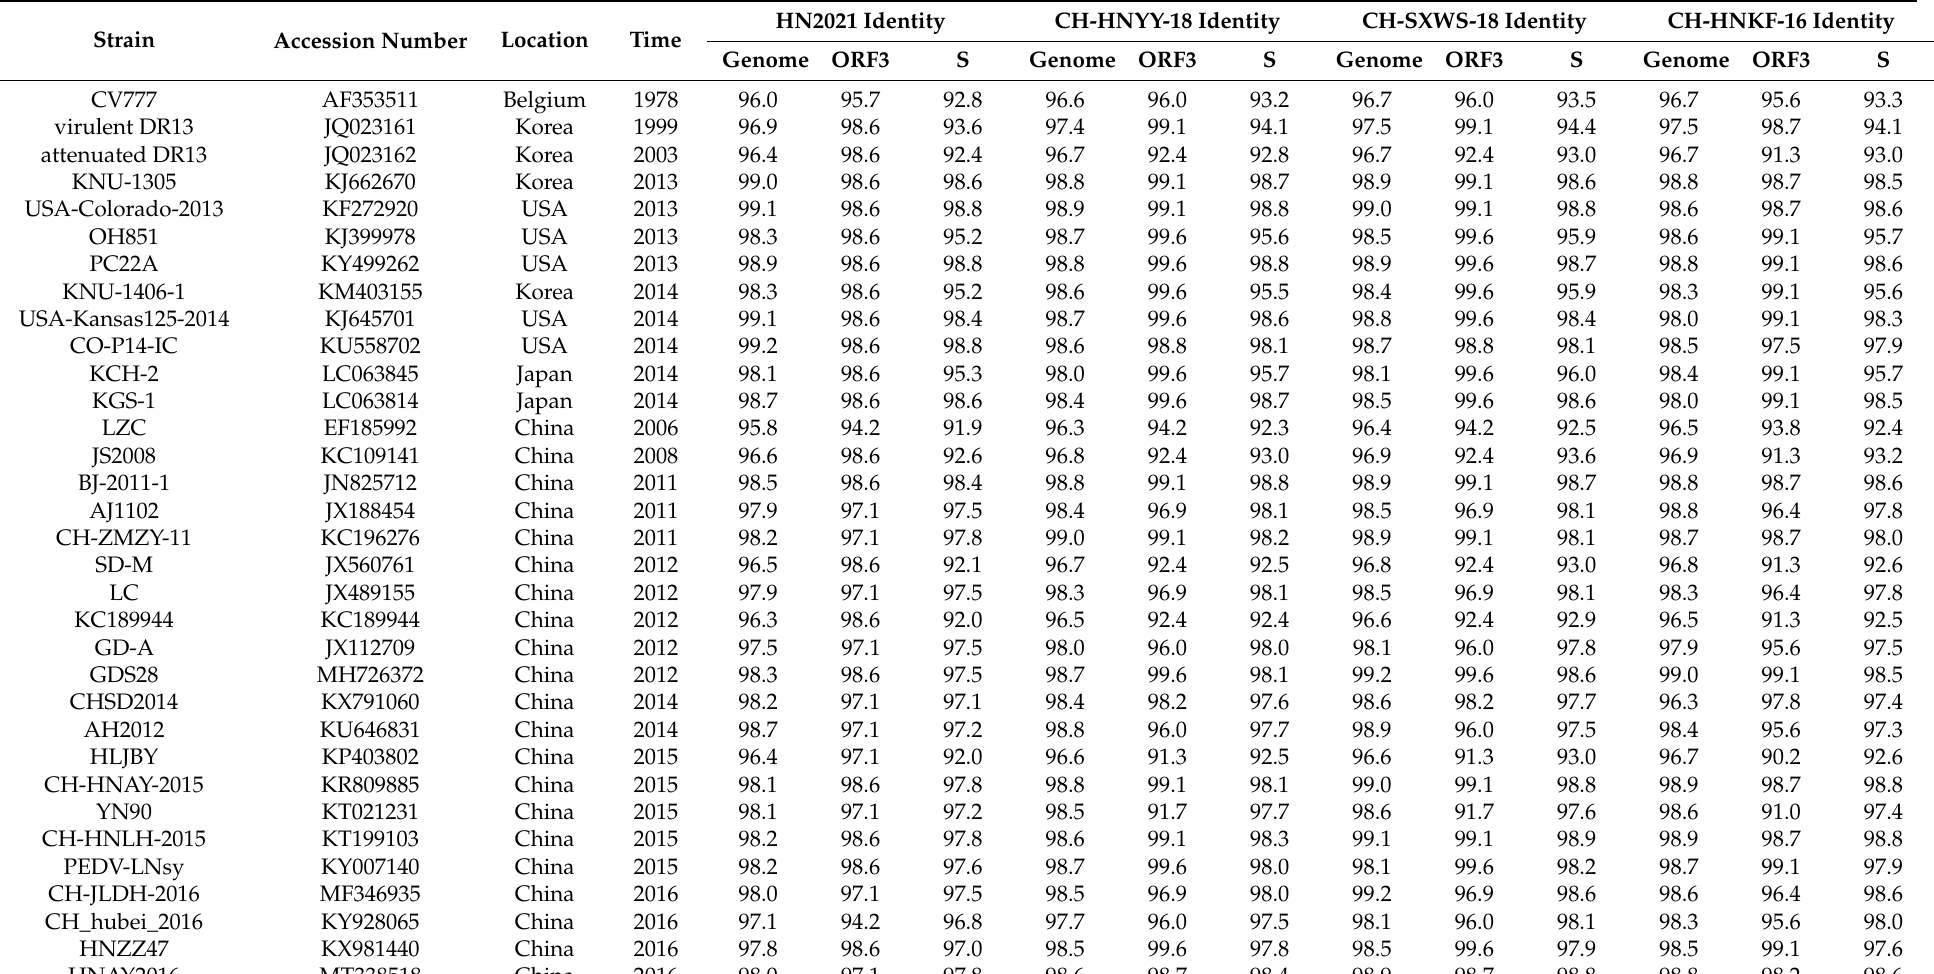
Table 1. Comparation of nucleotide and amino acid sequence identity (%) of different regions when comparing the 4 porcine epidemic diarrhea virus (PEDV) strains in this study and the representative